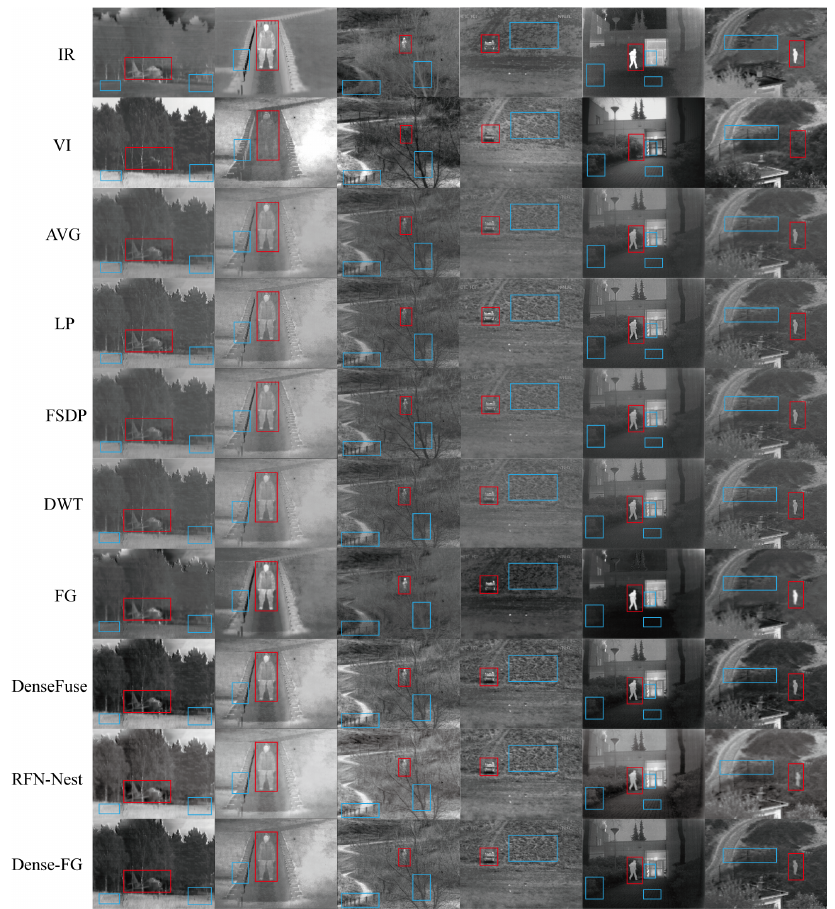
Figure 4. Comparison of fusion results of different algorithms. We label the infrared radiation information with a red box and the visible texture information with a blue box for clear